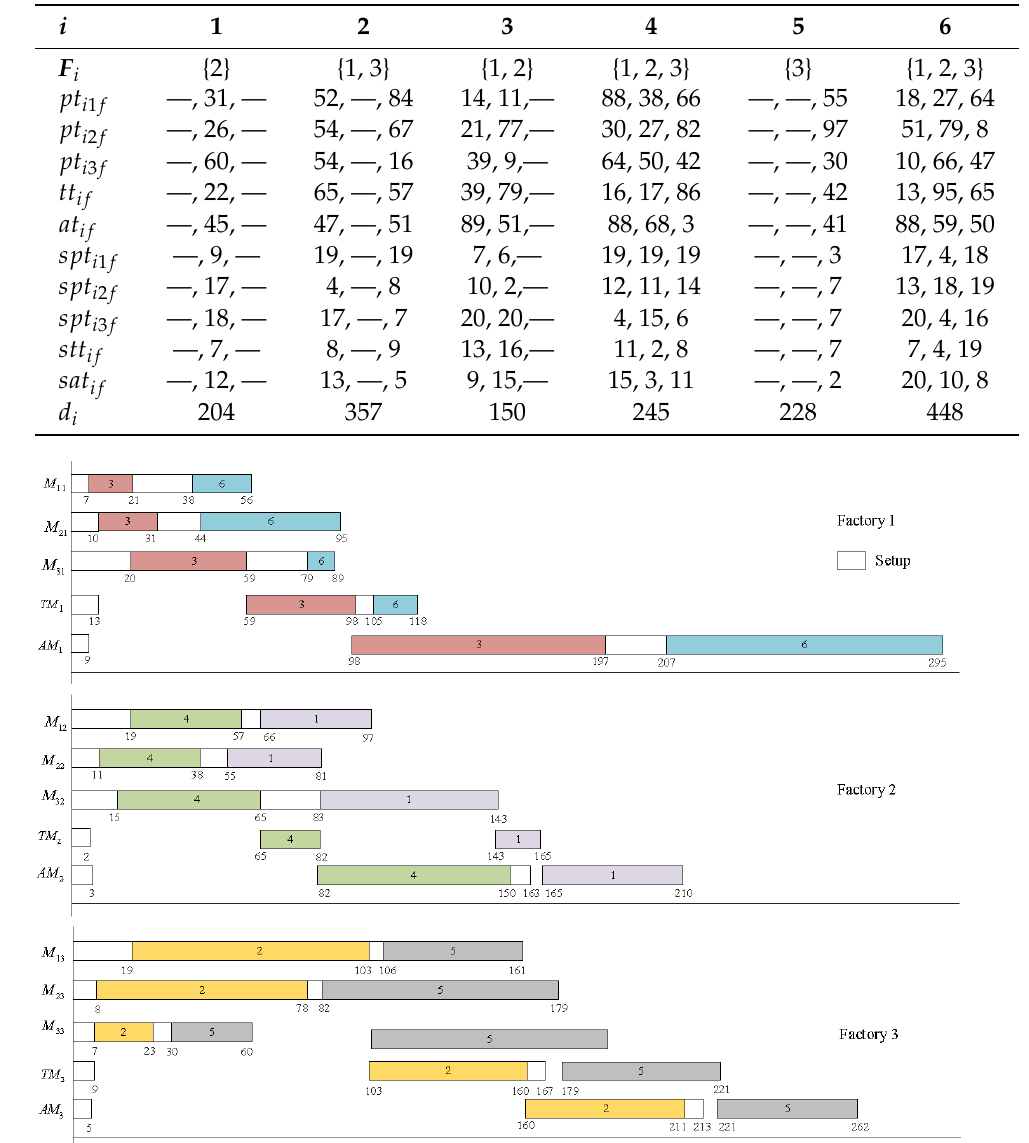
Table 2. An illustrative example.